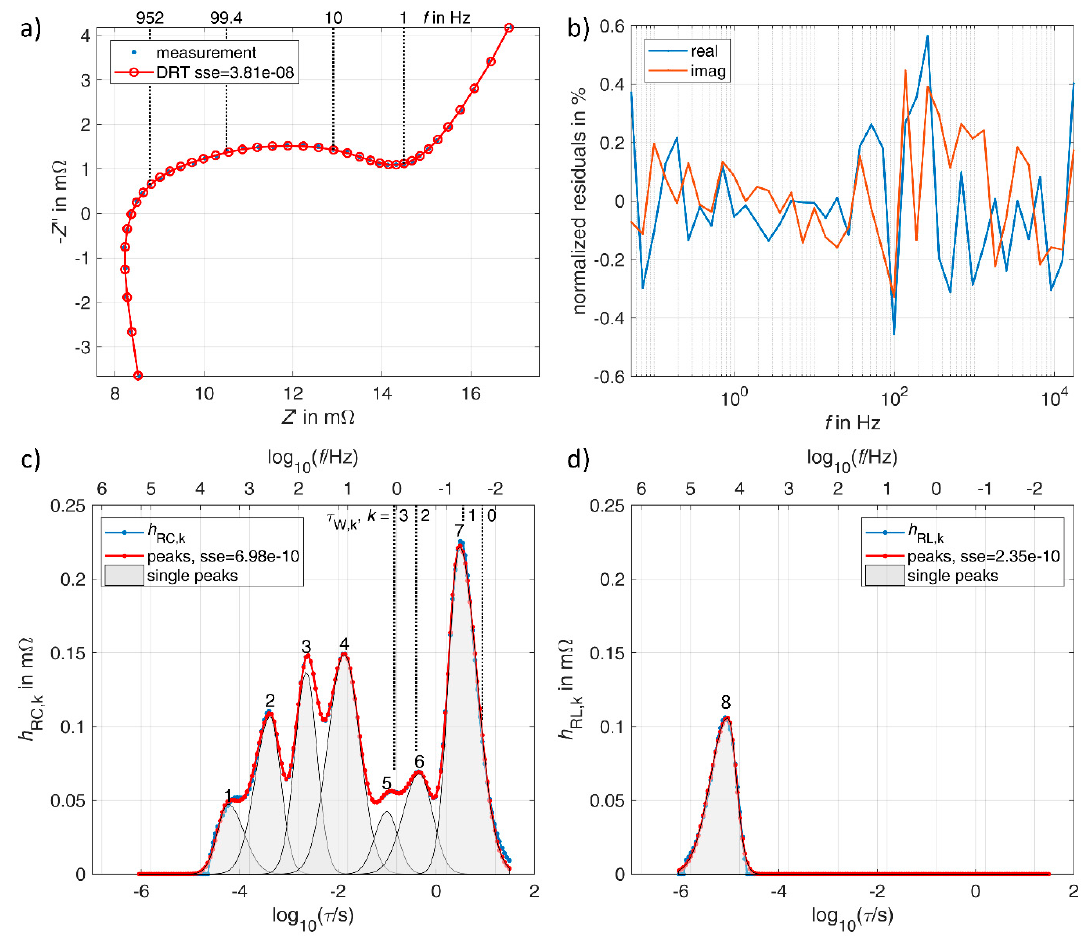
Figure 4. Generalized DRT analysis of a lithium-ion battery (A123 Systems, LFP-graphite, 2.6 Ah, 26650) with the sum of squared errors ( sse ) of each plot. ( a ) Measured and calculated impedance spectrum; ( b ) Normalized residuals of real and imaginary part of the impedance spectra of subplot ( a ); ( c ) Identified resistive-capacitive distribution of relaxation times function; ( d ) Identified resistive-inductive distribution of relaxation times function. Table 4. Identified polarization contributions of the lithium-ion battery comprising ohmic resistance, inductivity, capacitance, resistive-capacitive, and resistive-inductive elements.